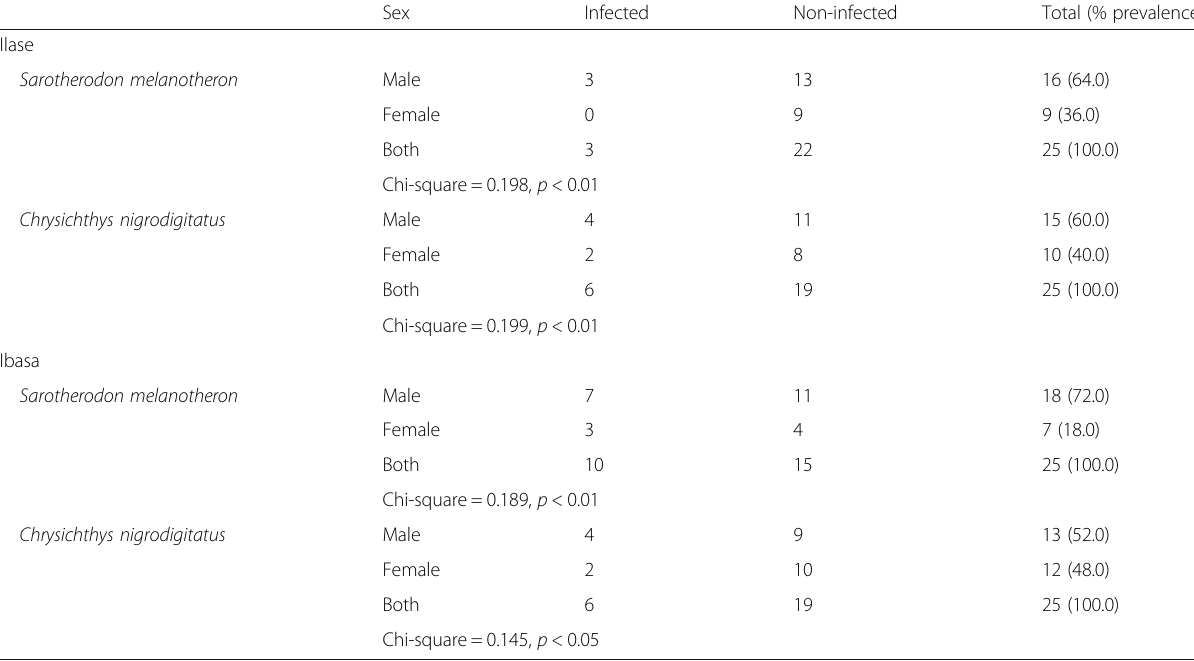
Table 11 Prevalence of intestinal helminth parasites of Chrysichthys nigrodigitatus and Sarotherodon melanotheron in Ibasa and Ilase creeks, Snake Island, Lagos